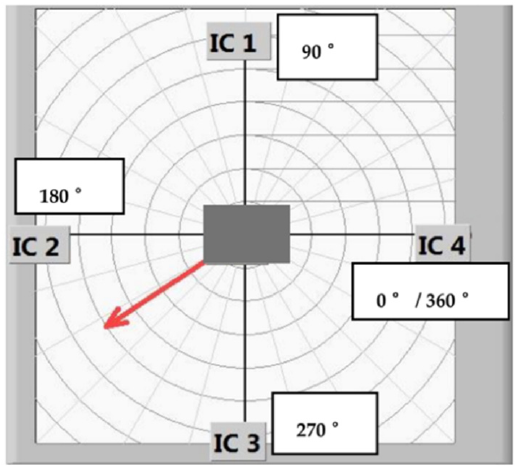
Figure 5. The detection of the H 2 O 2 flow direction by means of the square arrangement of four Pt100 elements, IC 1 to IC 4.